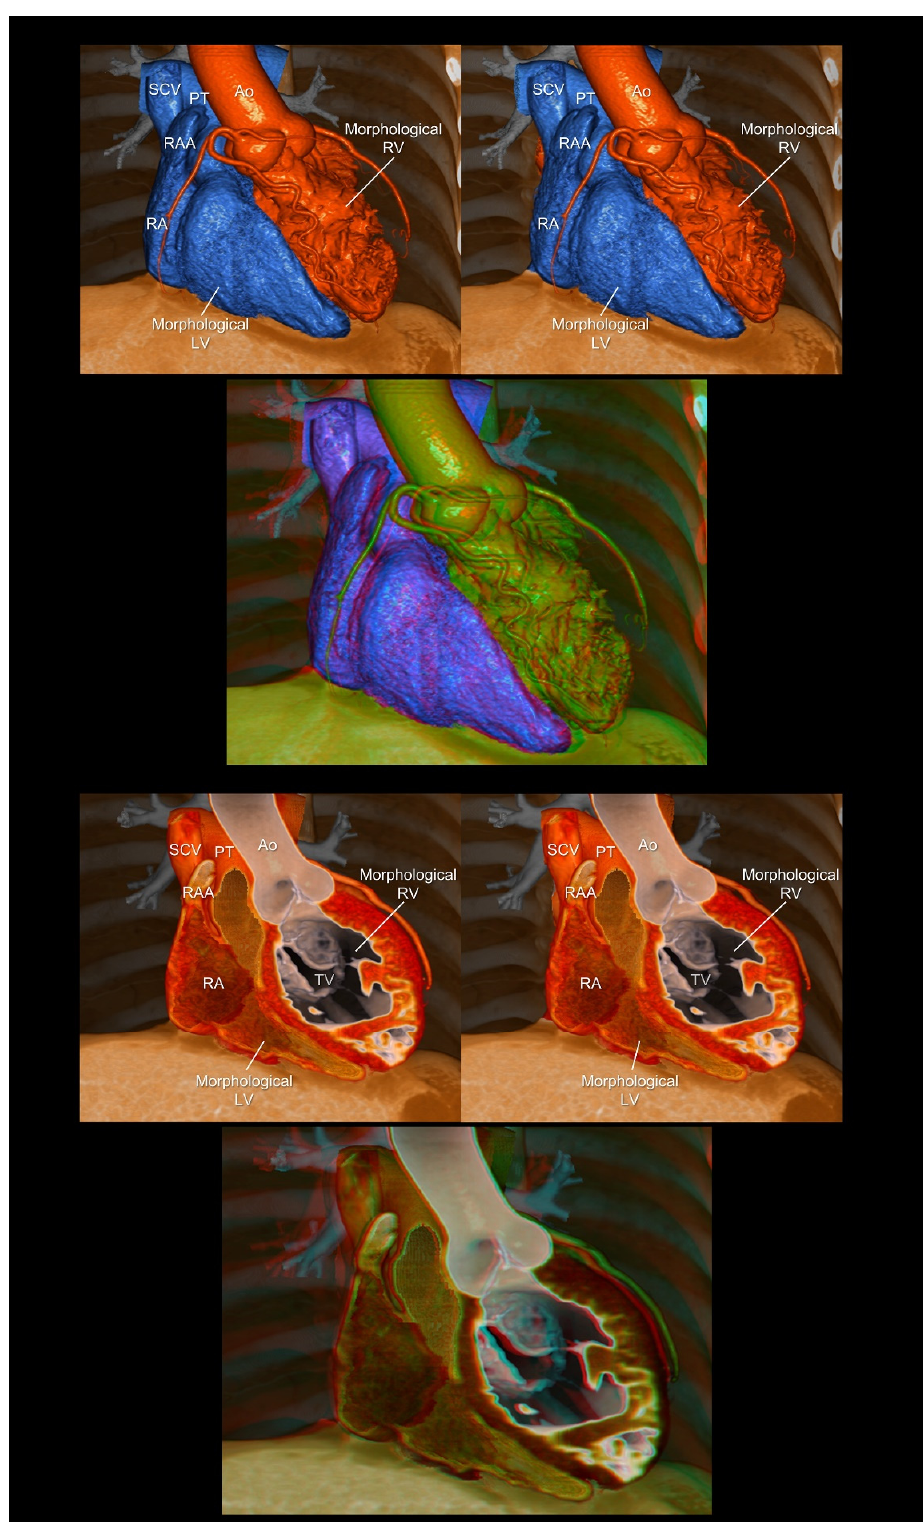
Figure 7. Endocast ( upper panels ) and virtual dissection images ( lower panels ) of the corrected transposition of the great arteries. The first and second panels are aligned for cross-eyed viewing. The third panel is the anaglyph. To see the anaglyph, anaglyphic glasses (red/cyan) are required. Ao, aorta; LV, left ventricle; PT, pulmonary trunk; RA, right atrium; RAA, right atrial appendage; RV, right ventricle; SCV, superior caval vein; TV, tricuspid valve.